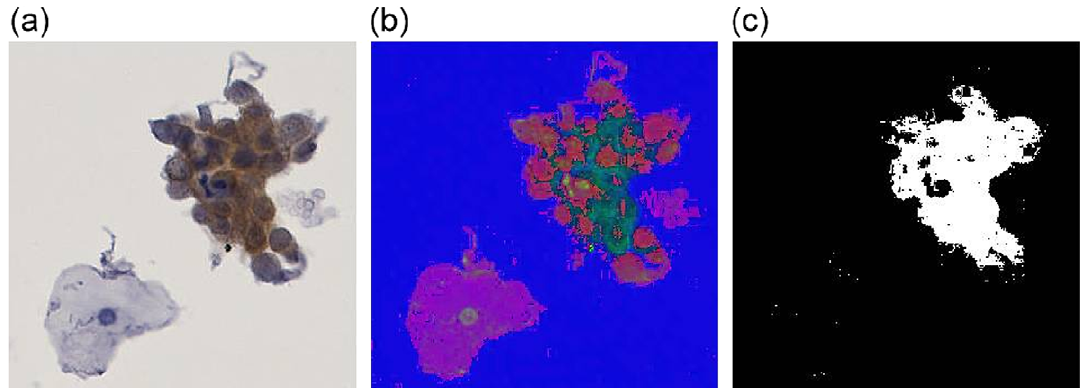
Fig. 6. Separation of p16-stained cells by HSV color space transformation. (a) Original image of a p16-stained cell cluster, (b) visualization of the same cluster in HSV color space (here displayed by interpreting the HSV values as RGB values), (c) applying a threshold in the HSV color space displays p16-stained components of the